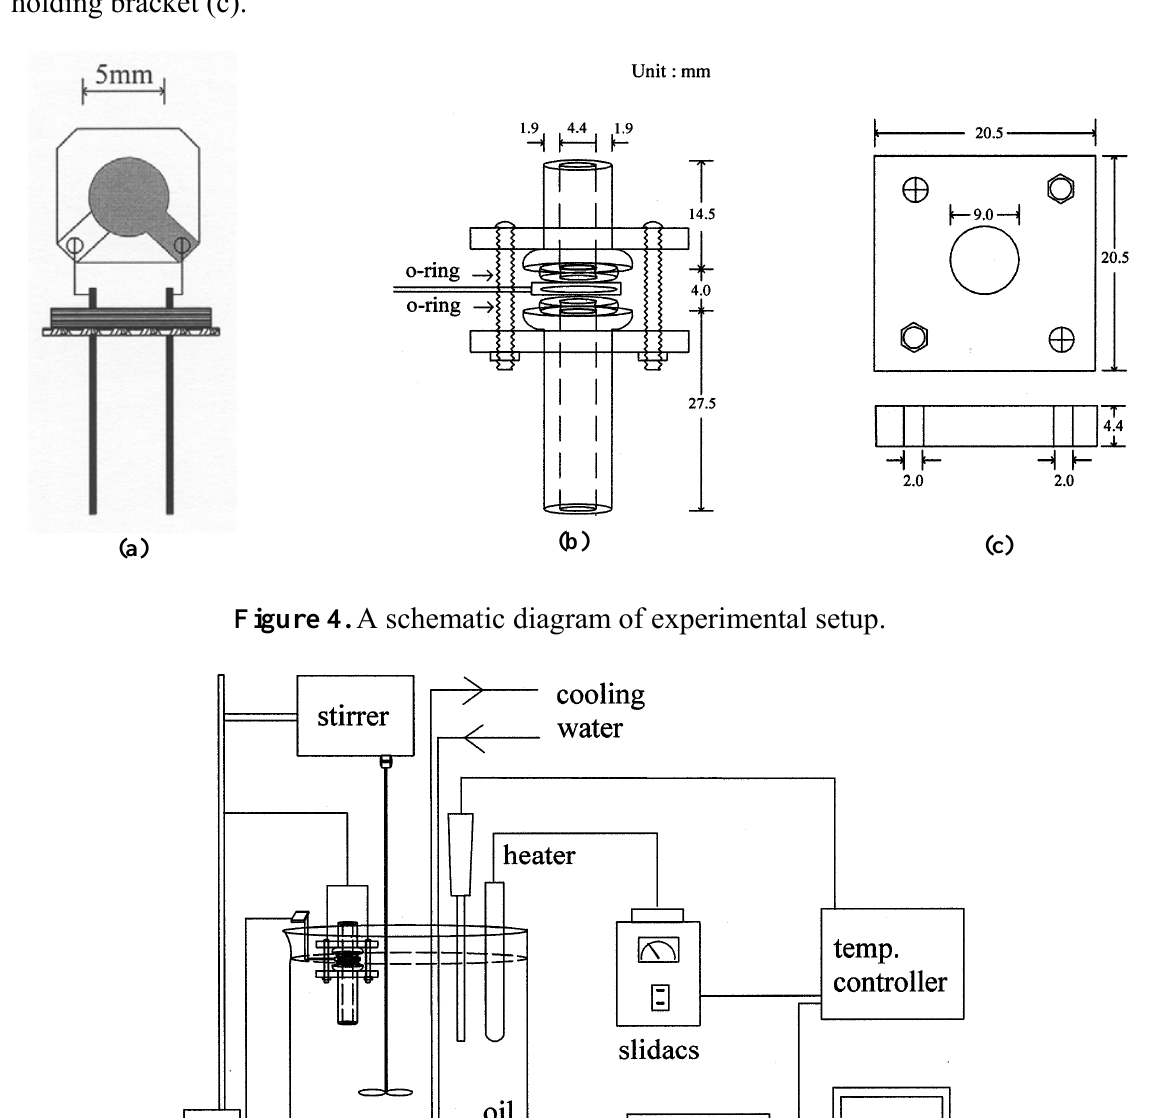
Figure 3. Schematic diagrams of quartz crystal resonator (a), resonator cell module (b) and holding bracket (c).